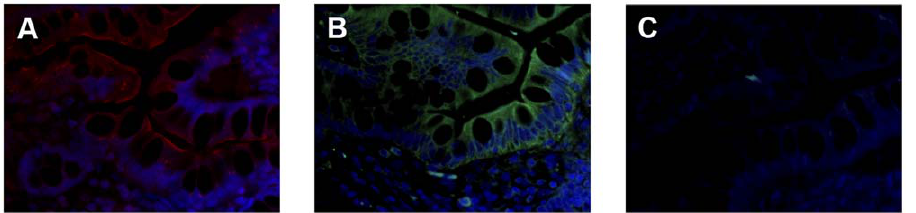
Figure 4. Fc e RI positive tissue reveals IgE binding activity. Immunofluorescence staining of serial sections from patient No. 8 revealed IgE binding in (A) Fc e RI a -chain (red) positive epithelial cells being incubated with (B) monoclonal NiP-specific humanized IgE antibodies (green). (C)